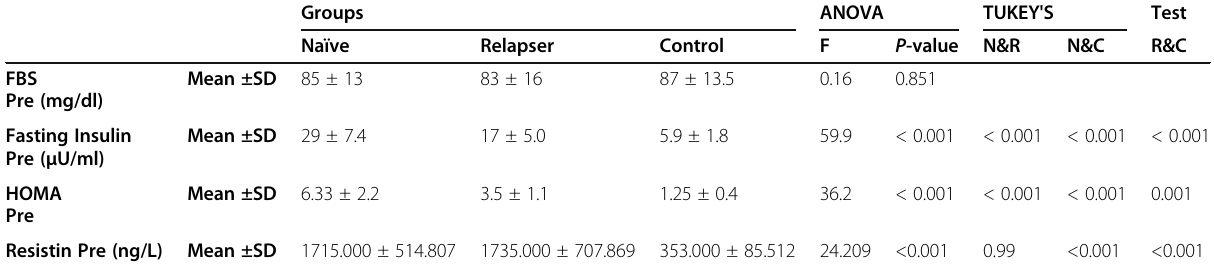
Table 2 Comparison between the three groups regarding baseline Fasting blood sugar, fasting insulin, HOMA-IR and resistin